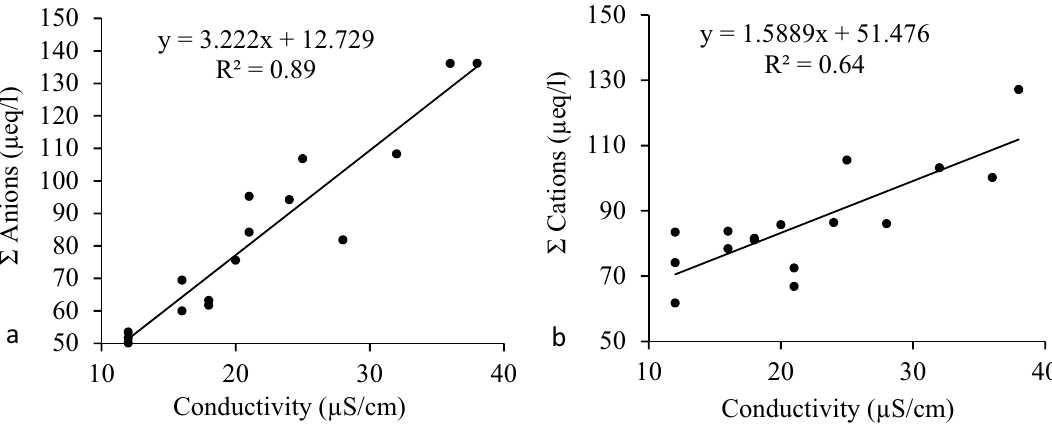
Figure 3. Scatter plot of conductivity against ( a ) sum of anions and ( b ) sum of cations.